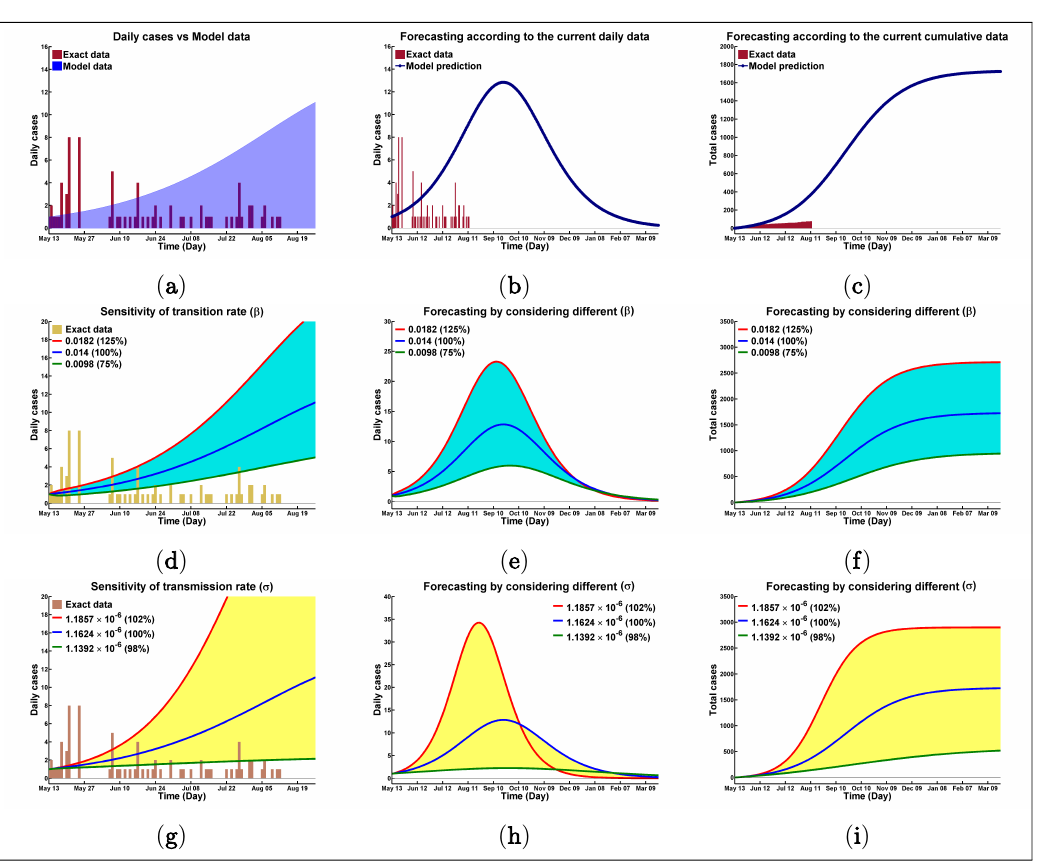
Figure 6: Visual presentation of model good fitting with real data. Figure A1. Visual presentation of a model that has a good fitting with real